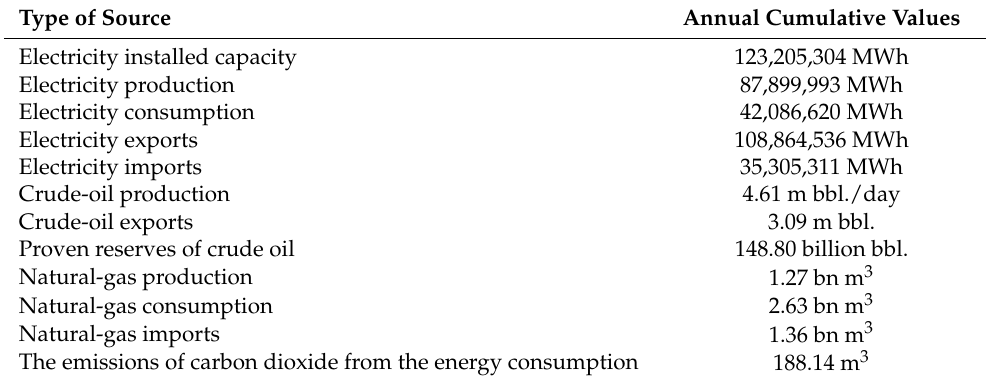
Table 2. Iraq’s energy profile from fossil fuels [41].